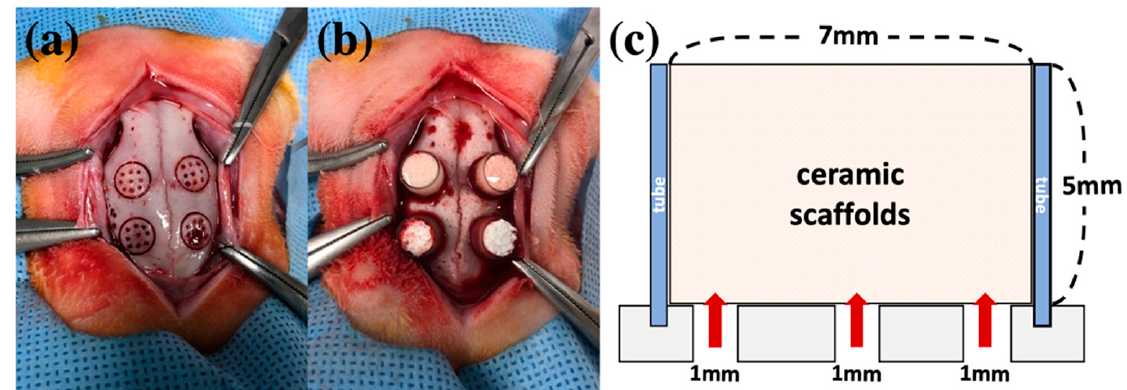
Figure 5. Protocol of animal experiments. ( a ) Four defects in calvarial area. A round border of 7 mm in diameter with nine holes that were 1 mm in diameter were created. ( b ) Application of scaffold into polycarbonate tubes ( Φ 7 × 5 mm). ( c ) Schematic of the animal experiment.